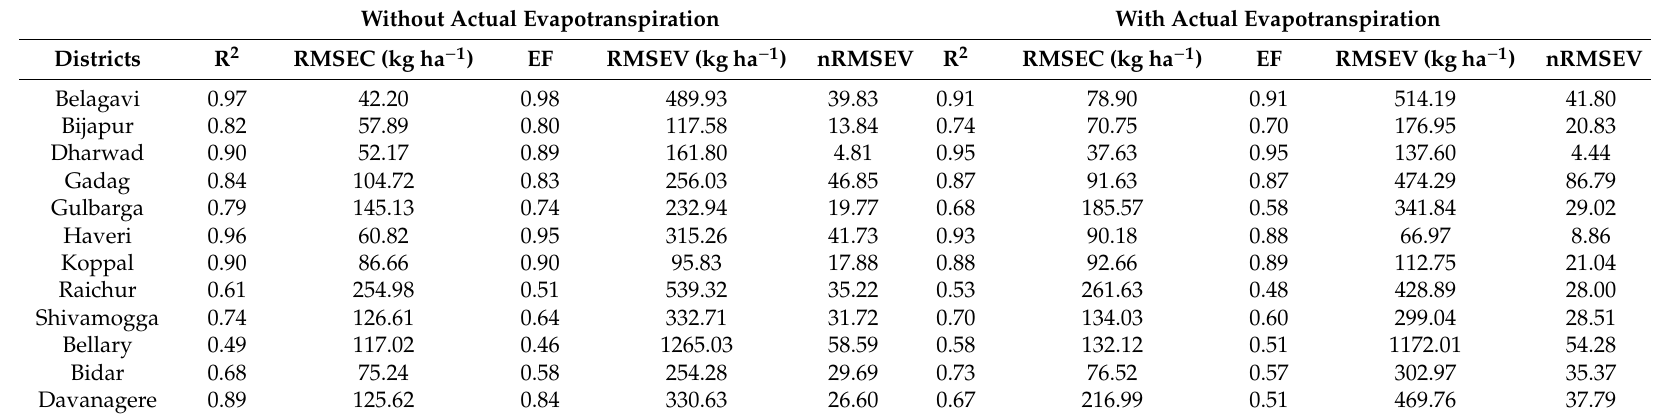
Table 6. Quantitative measures obtained for sorghum yield prediction of Karnataka using